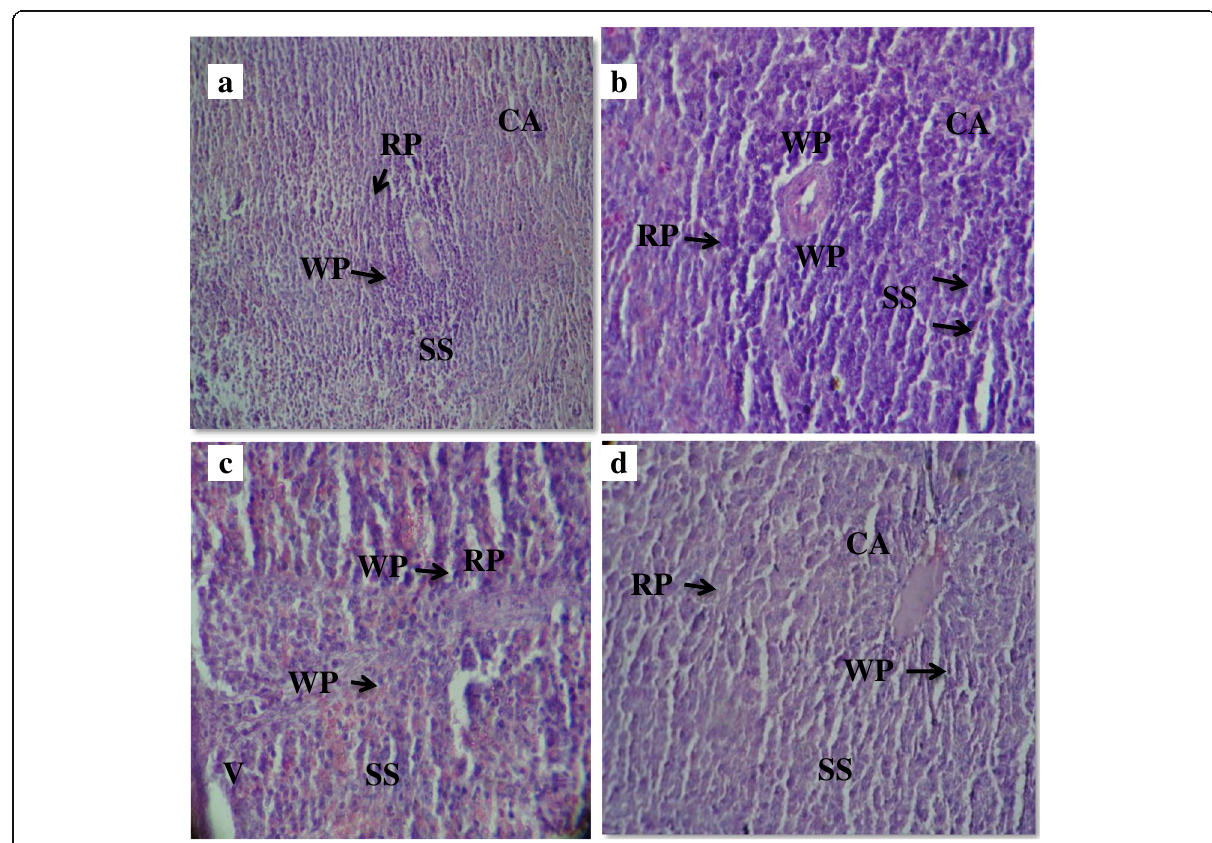
Fig. 3 Spleen histological sections of rats in sub-acute toxicity study. a Normal control group; b 10 mg/kg BA-treated group; c 10 mg/kg UA- treated group; d 50 mg/kg APAP-treated group (× 25, H&E stained). WP — white pulp, RP — red pulp, SS — splenic septa, CA — central artery, V —